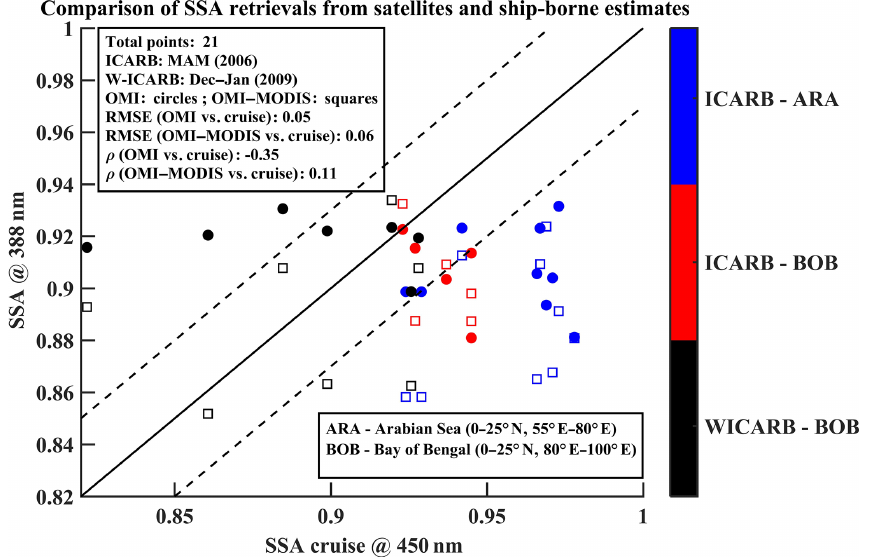
Figure 8. Comparison of SSA OMI (circles) and SSA OMI–MODIS (squares) with cruise measurements. Each point represents the mean SSA in a 2 ◦ box surrounding each cruise location averaged over the respective cruise time period. Due to the sparse nature of OMI–MODIS retrieval, the total number of points common to both the cruise and the satellite estimates is only 21. The solid black line is the y = x line. The dotted lines represent the ± 0 . 03 range. The colour bar represents the cruise name and the region where the measurements were made. ICARB (Integrated Campaign for Aerosols, Gases and Radiation Budget) during the March–April–May (MAM) period in 2006; W-ICARB (winter ICARB) during the period from December to January (2008–2009); ARA (Arabian Sea); BOB (Bay of Bengal). Discrepancies between the satellite retrievals and cruise measurements were seen during the ICARB cruise when elevated aerosols were predominantly present over both of the regions and might not have been detected by the cruise